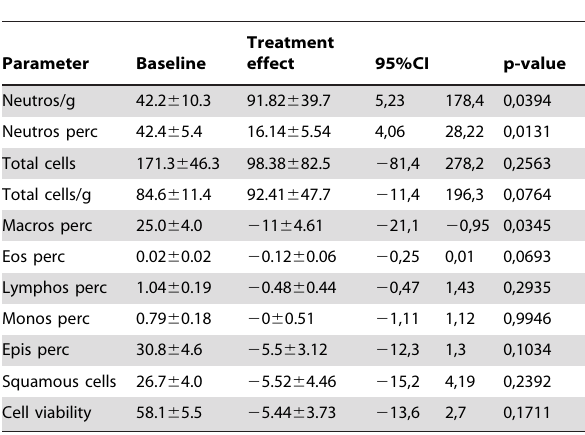
Table 2. Differential cell count in induced sputum at baseline and the exposure effect adjusted for period 6 hours after the start of exposure to ozone compared to clean air.